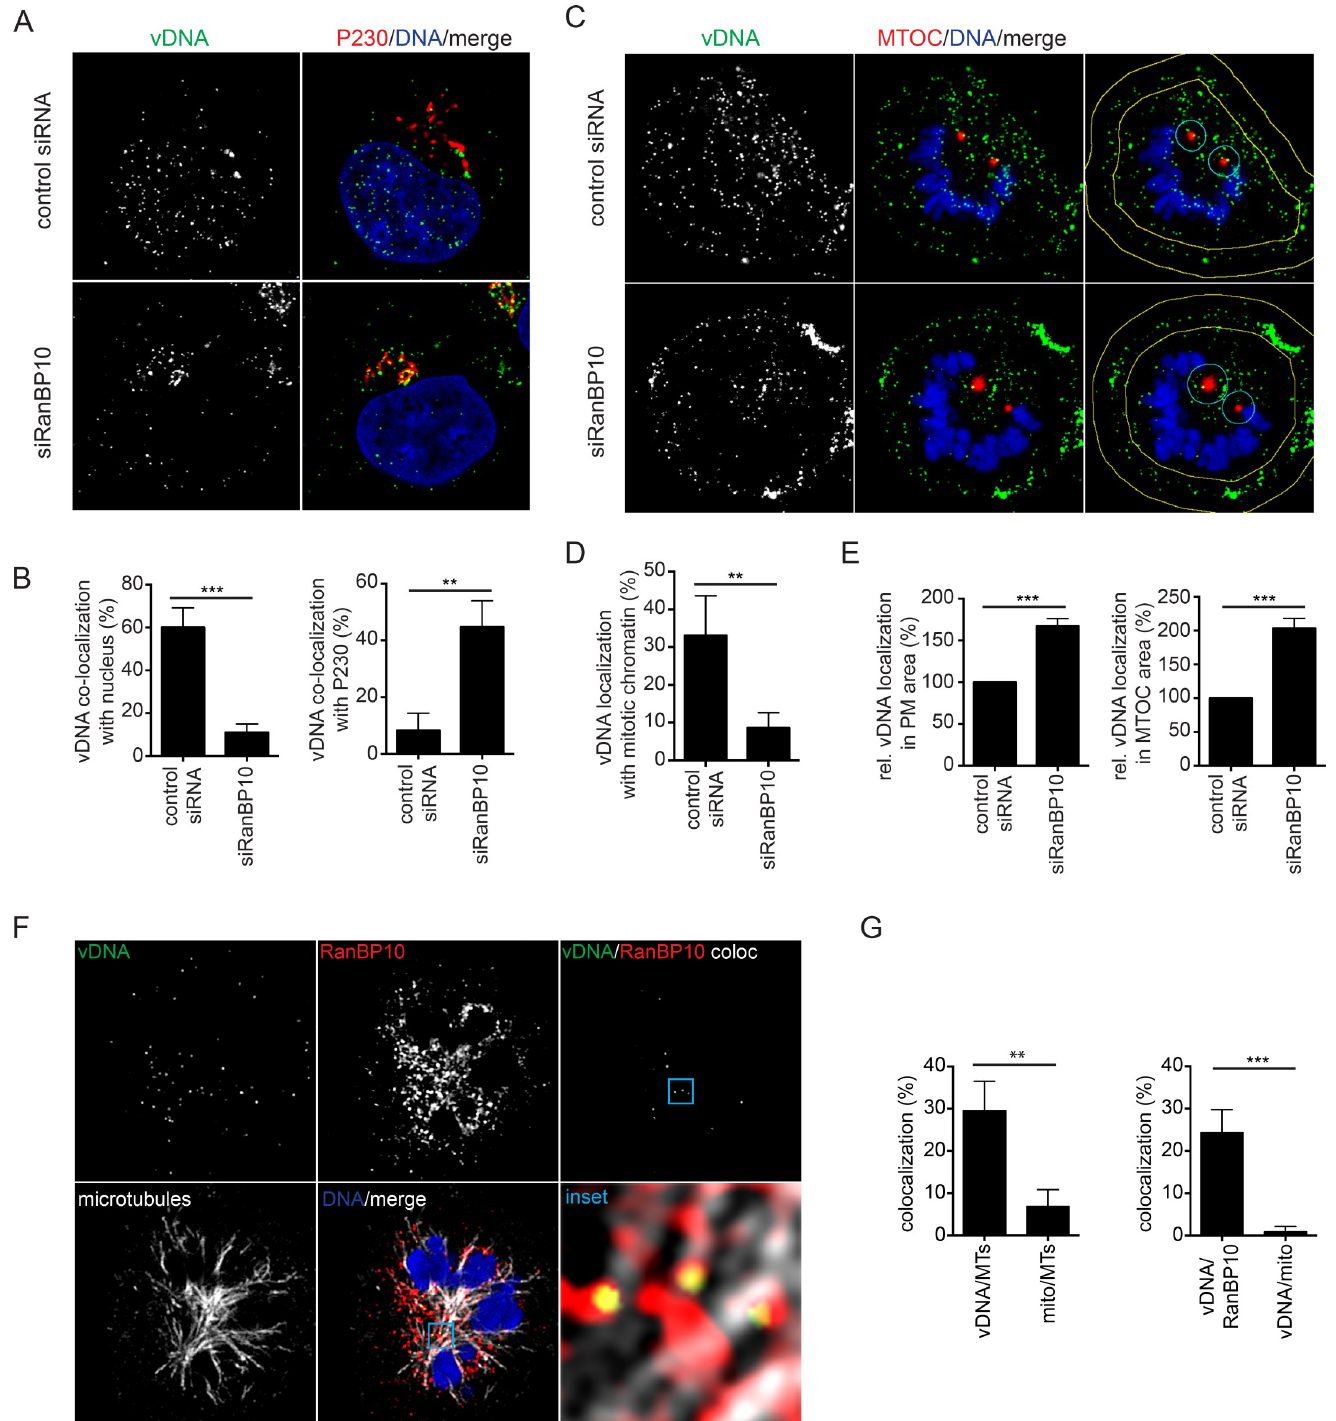
Fig 3. RanBP10 facilitated nuclear delivery of incoming HPV16 viral DNA. vDNA from incoming EdU-labelled HPV16 PsV was detected using EdU Click-iT chemistry, nuclei were stained by Hoechst-33258. All images were acquired by confocal microscopy. Images represent single medial slices. The degree of overlapping signals from at least three independent experiments was quantified using IMARIS. (A) RNAi of RanBP10 in HeLa cells was followed by infection with EdU-labelled HPV16. Cells were fixed at 20 h.p.i., and stained with an anti-P230 antibody and Hoechst-33258 to indicate the TGN and nucleus, respectively. (B) Quantification of co-localized vDNA signals with the nucleus or P230. At least 35 cells were analyzed in three independent experiments. The error bars indicate the SD. (C) Experiments as in (A) were performed in mitotically arrested cells. Yellow lines in the right column indicate margins for quantification of (E) . (D) Quantification of